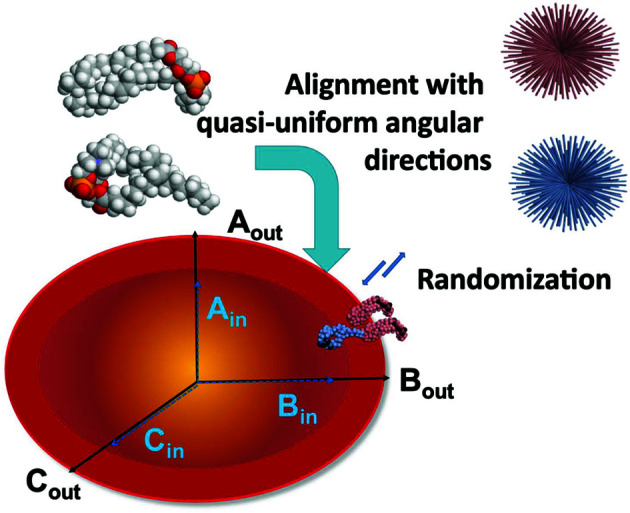

ELLLIP builds a liposome as two nested quasi-ellipsoids corresponding to the inner and outer liposome leaflets. The ellipsoidal shapes can be user specified by defining the lengths of the ellipsoid semi-axes (A
out, B
out and C
out for the outer leaflet, and A
in, B
in and C
in for the inner leaflet). Atomic models of the constituent lipids (grey beads) are placed on angular grids (top right) that define the outer (pink) and inner (blue) leaflets of the liposome. After the grids have been populated with lipids, a randomization step occurs in which the lipid molecules are displaced to account for possible disorder.